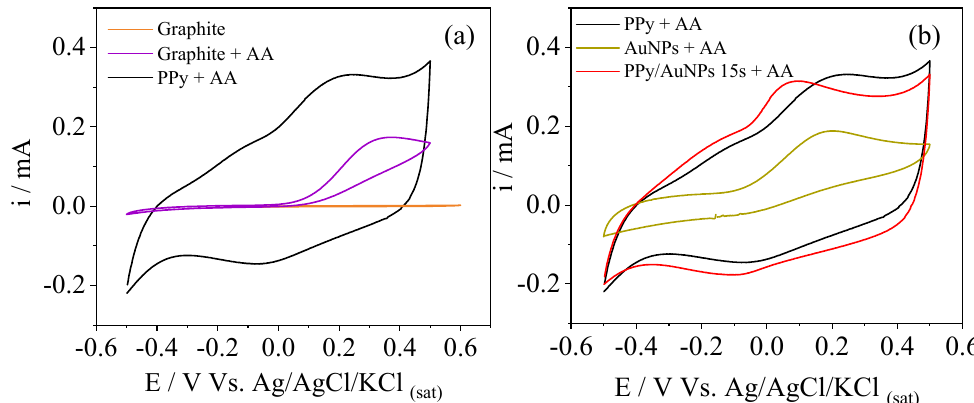
Figure 5. ( a ) Cyclic voltammetry of pencil graphite electrode in PBS electrolyte (orange line), bare pencil graphite (purple line), and PPy (black line). ( b ) Cyclic voltammetry of PPy (black line), AuNPs (yellow line), and PPy/AuNPs 15 s (red line) in PBS electrolyte containing 5 mmol L − 1 of AA. Scan rate = 20 mV s − 1.